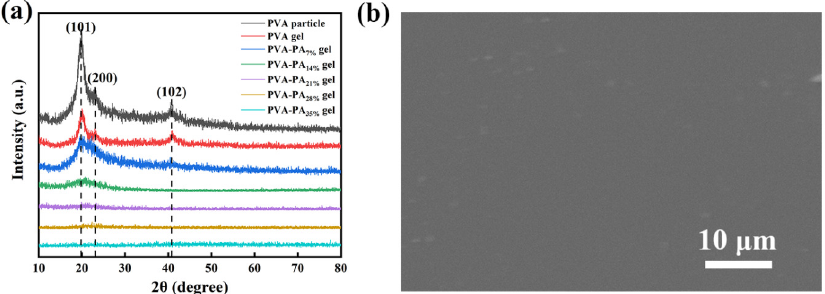
Figure 4. ( a ) XRD patterns of PVA-PAx hydrogels with different PA content. ( b ) SEM images of PVA-PA 21% hydrogels.